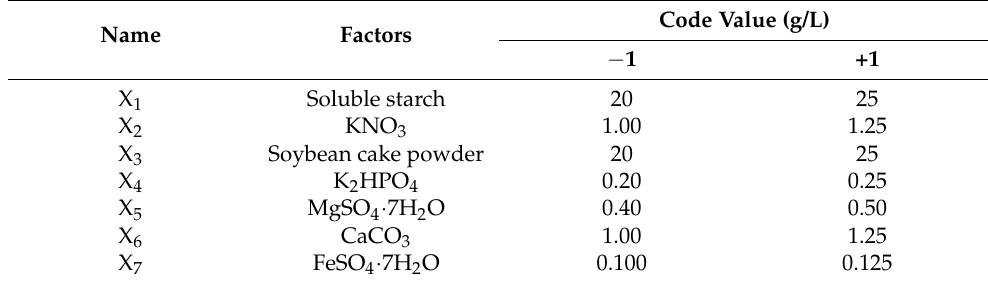
Table 1. The level and code of variables chosen for